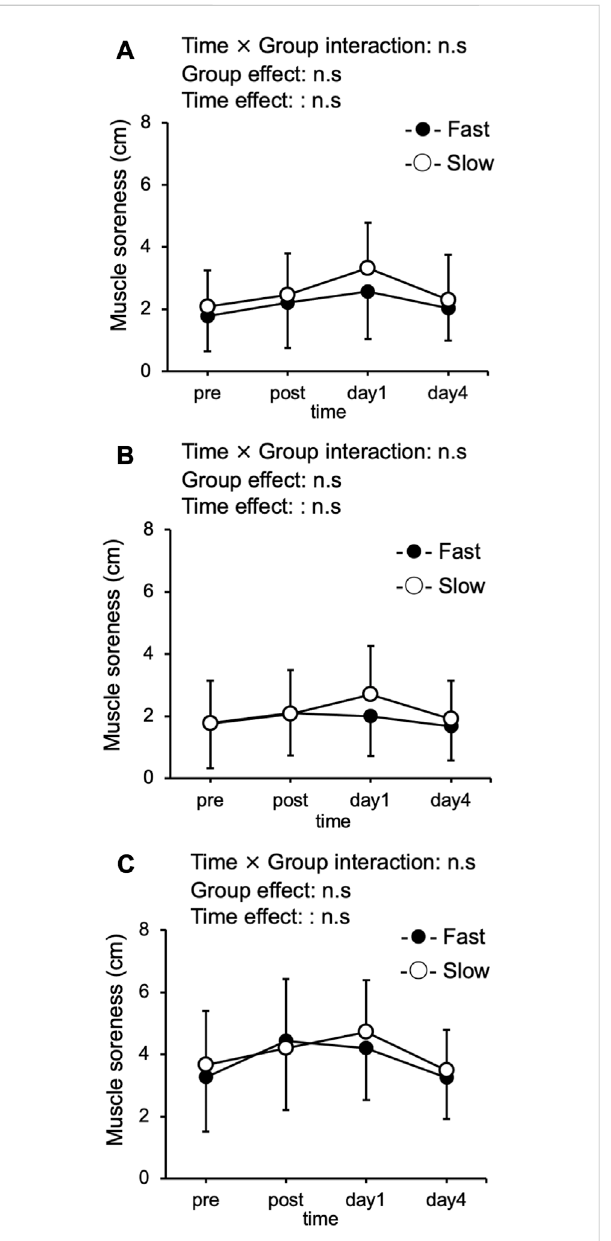
slow velocity session (Slow) and fast velocity session (Fast).